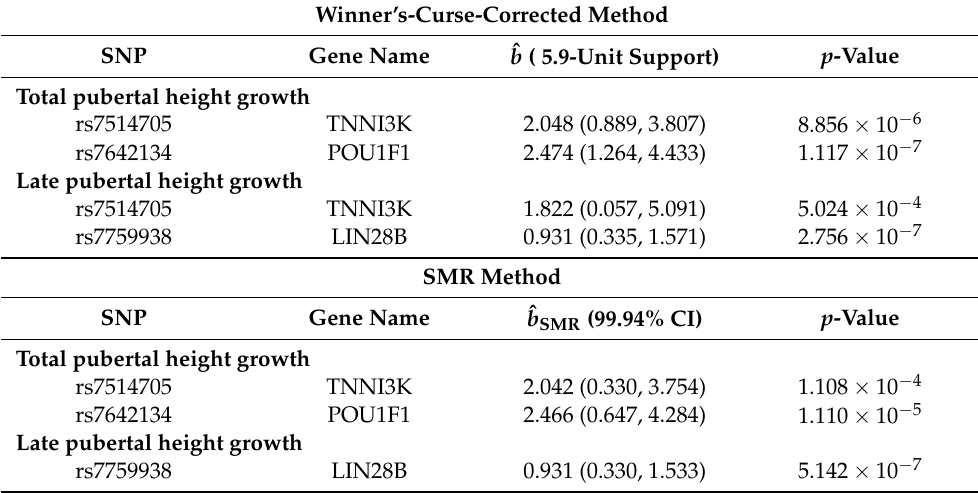
Table 2. Results for the effects of age at menarche on total pubertal height growth and late pubertal height growth. To correct for the 84 IV SNPs, the support is 5.9-unit and the nominal coverage of the CI is 0.9994 (= 1 − 0.05/84 ) . This support excludes 0 if and only if the T statistic is significant at the level 0.05/84. The p -value is for the null H 0 : b = 0. It is computed from the T statistic (the winner’s-curse-corrected method) or the T SMR statistic (the SMR method). Winner’s-Curse-Corrected